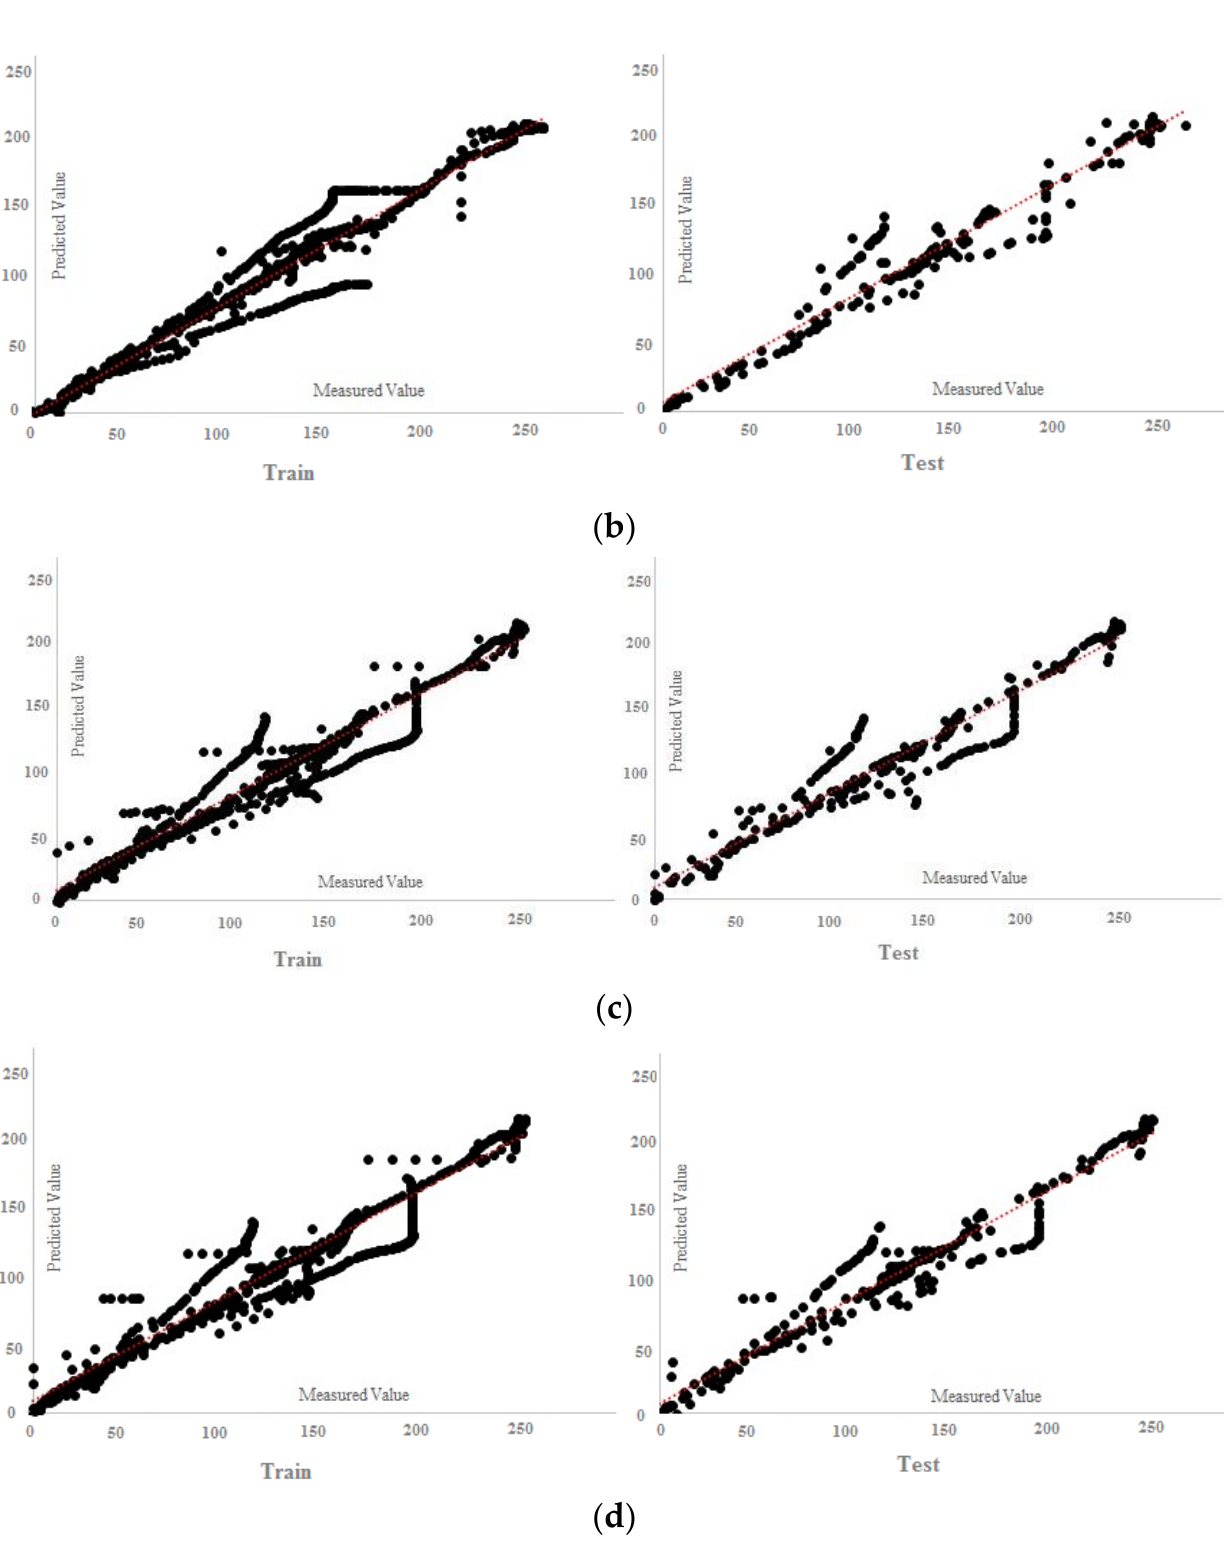
Figure 26. ELM and RBF regression charts: ( a ) ELM (four inputs), ( b ) ELM (seven inputs), ( c ) RBF (seven inputs) and ( d ) RBF (four inputs).